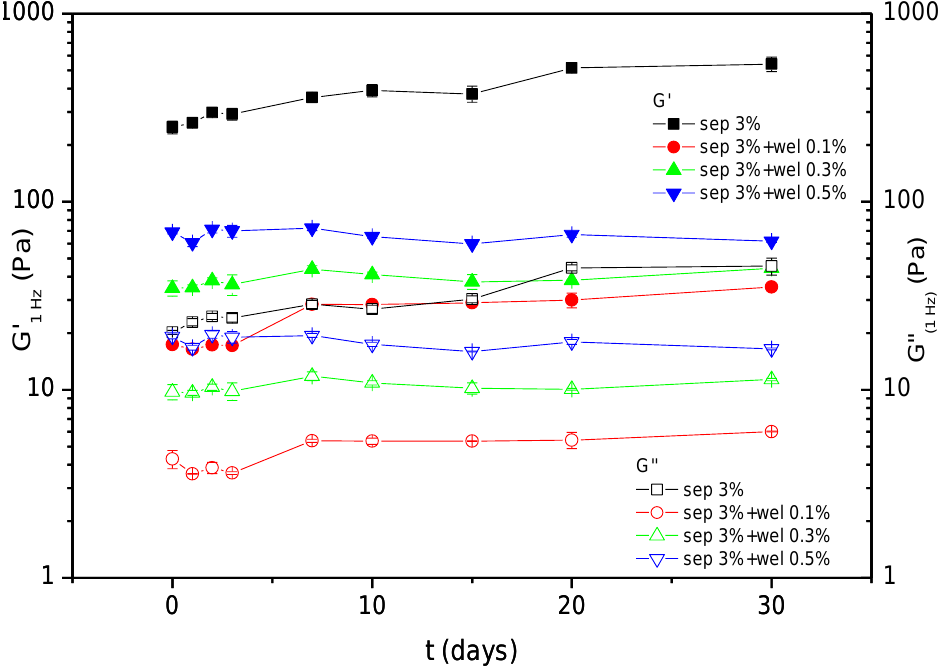
Figure 6. Storage modulus (G ’ 1Hz ) and loss modulus (G ’’ 1Hz ) measured at 1 Hz as a function of aging time for sepiolite gel 3%wt. mixtures with different concentrations of welangum at 20 °C. The error bars shown correspond to standard